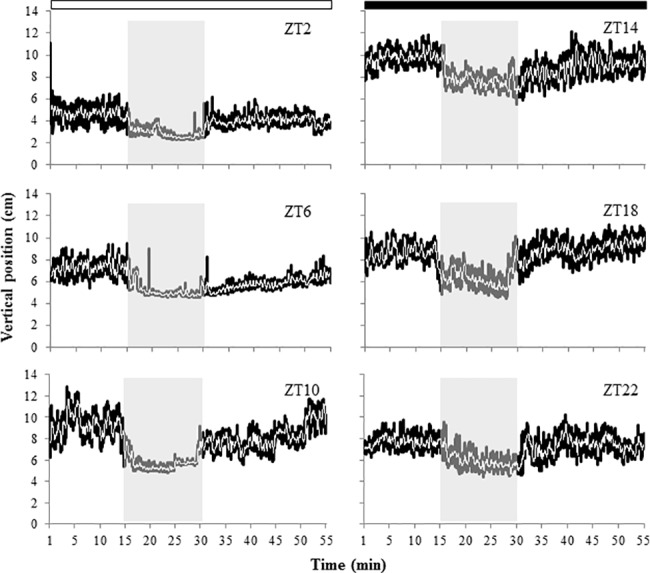
Average position (cm) of adult zebrafish in the water column before, during and after exposure to 1% ethanol for 15 min at different times of the day (tests at ZT2, ZT6, ZT10, ZT14, ZT18 and ZT22) (n = 14 fish/ZT).Graph definitions as given for Fig 2.